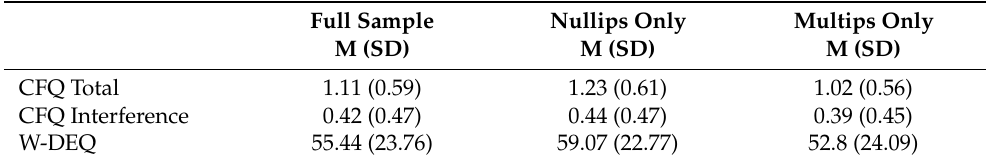
Table 2. Means (M) and standard deviations (SD) for the Childrbith Fear Questionnaire (CFQ; total and subscales) and the Wijma Delivery Expectations Questionnaire